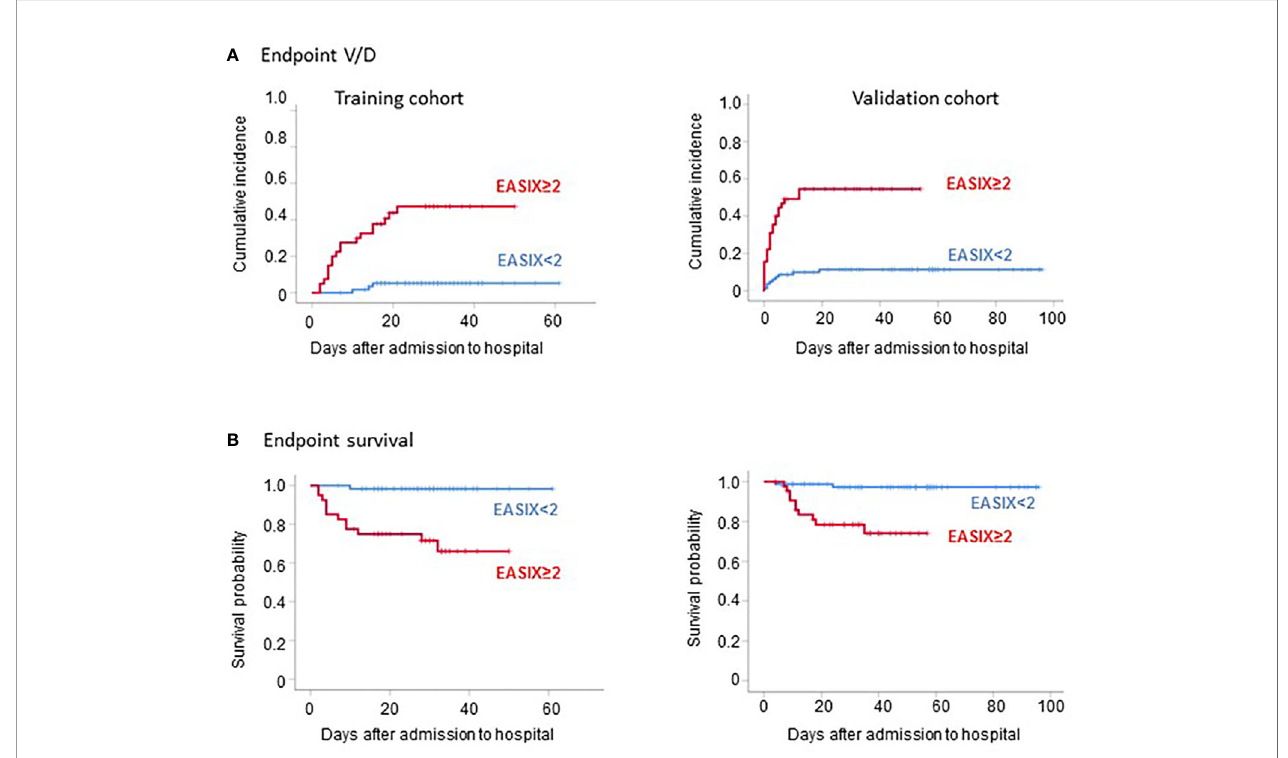
FIGURE 1 | Outcome of COVID-19 patients according to EASIX. Outcome of COVID-19 patients according to EASIX (cut-off 2) in the training cohort (left panels) and the validation cohort (right panels). (A) Cumulative incidence of severe courses of disease (mechanical ventilation and/or death, V/D). (B) Kaplan-Meier plots of overall survival.